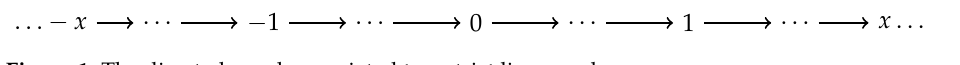
Figure 1. The directed graph associated to a strict linear order.